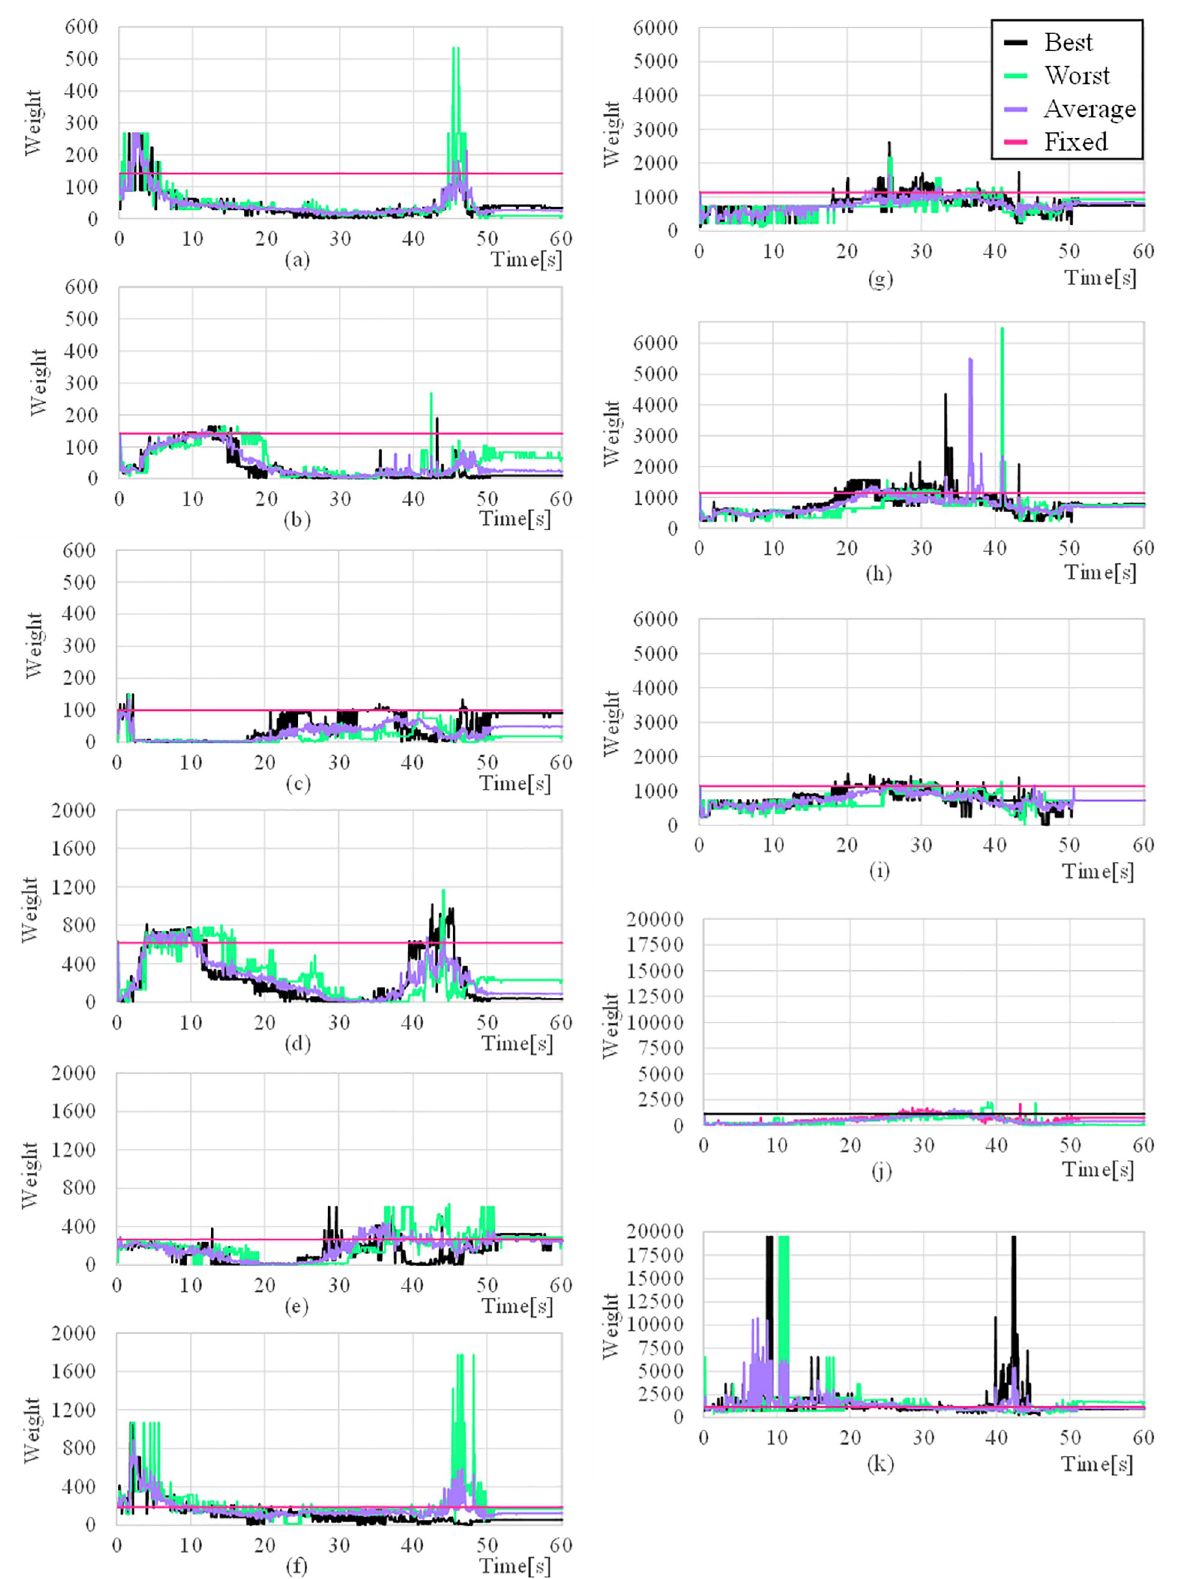
Fig 15. Weighting matrix elements (a) w x (b) w y , (c) w z (d) w ϕ (e) w θ (f) w ψ (g) w W1 (h) w W2 , (i) w W3 (j) w C1 (k) w C2 . https://doi.org/10.1371/journal.pone.0253771.g015 PLOS ONE | https://doi.org/10.1371/journal.pone.0253771 July 2,